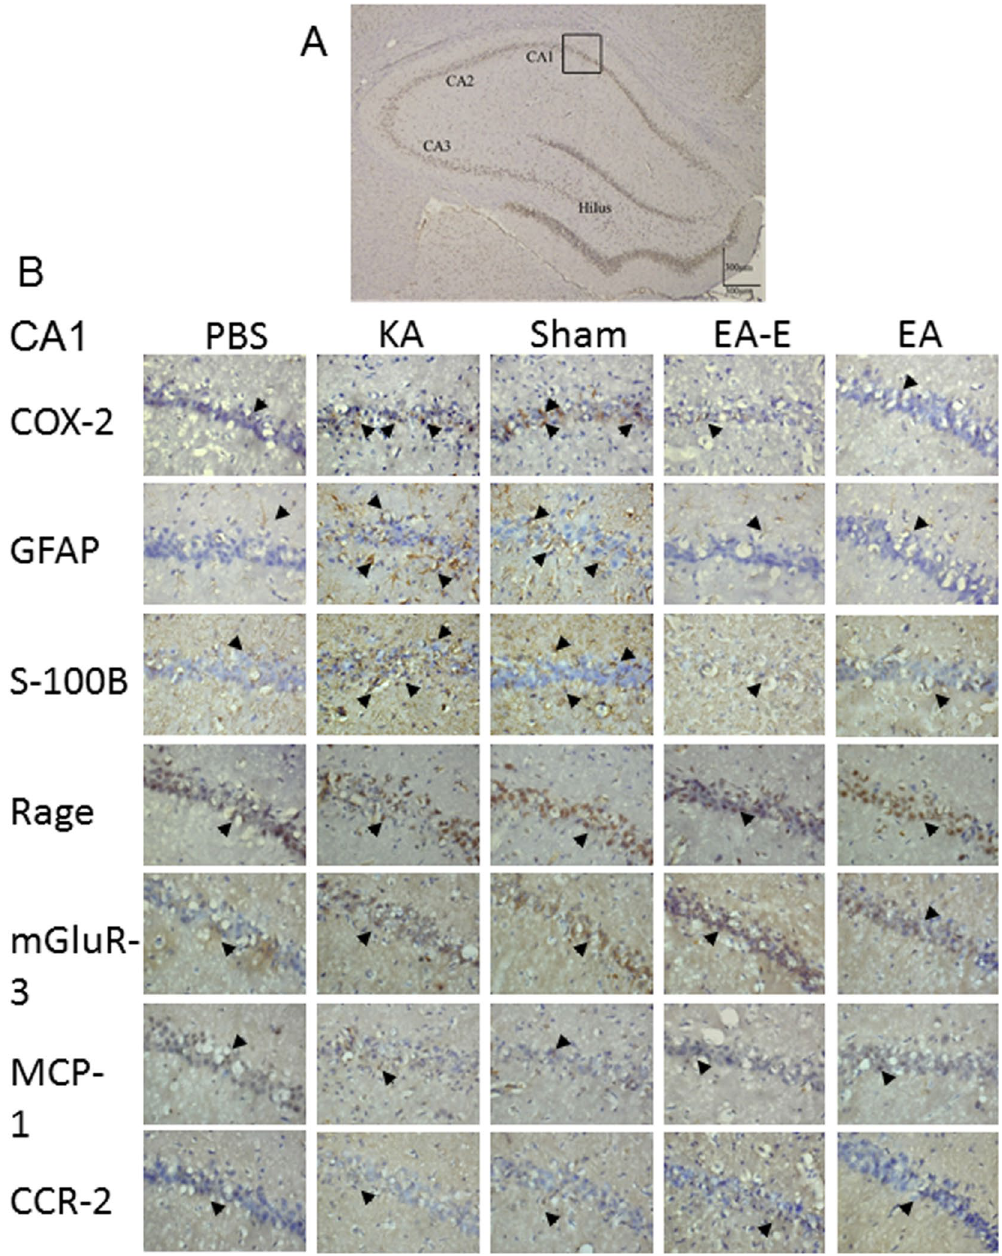
Figure 3. Effects of electric stimulation at the ear and electro-acupuncture at ST36–ST37 on the counts of COX-2, GFAP, S100-B, RAGE, mGluR3, MCP-1, and CCR2 immunoreactive cells in kainic acid (KA)-induced epileptic seizure rats. The CA1, CA2, CA3, and hilus regions of the hippocampus ( A ). The counts of COX-2, GFAP, and S100-B immunoreactive cells were higher in the KA group (KA) and sham group (Sham) than in the normal group (Normal), whereas these counts were decreased in the auricular group (Ear) and Zusanli group (Zusanli). The counts of RAGE, mGluR3, MCP-1, and CCR2 immunoreactive cells were similar among the normal, KA, sham, and auricular groups ( B ). Immunoreactive cell (arrowhead); B image is 400 × in the CA1 region; n =